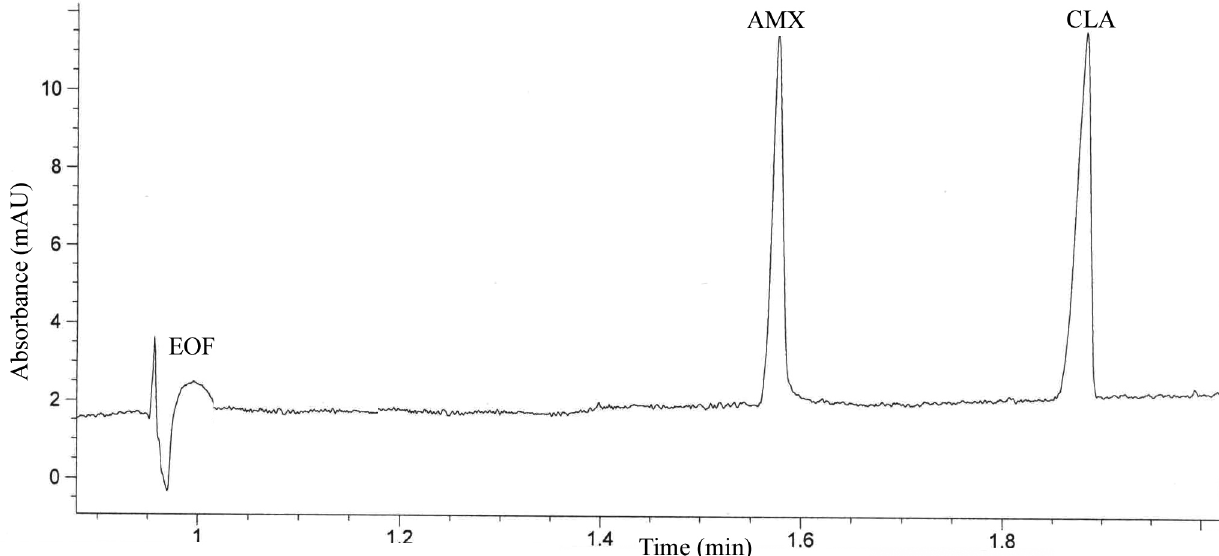
FIGURE 2 - Capillary electrophoretic separation of AMX and CLA from mixture (experimental conditions: 25 mM sodium tetraborate BGE, pH – 9.30, voltage + 25 kV, temperature 25 o C, hydrodynamic injection 50 mbar/1 sec., sample concentration 10 µ g mL -1 , UV detection 230